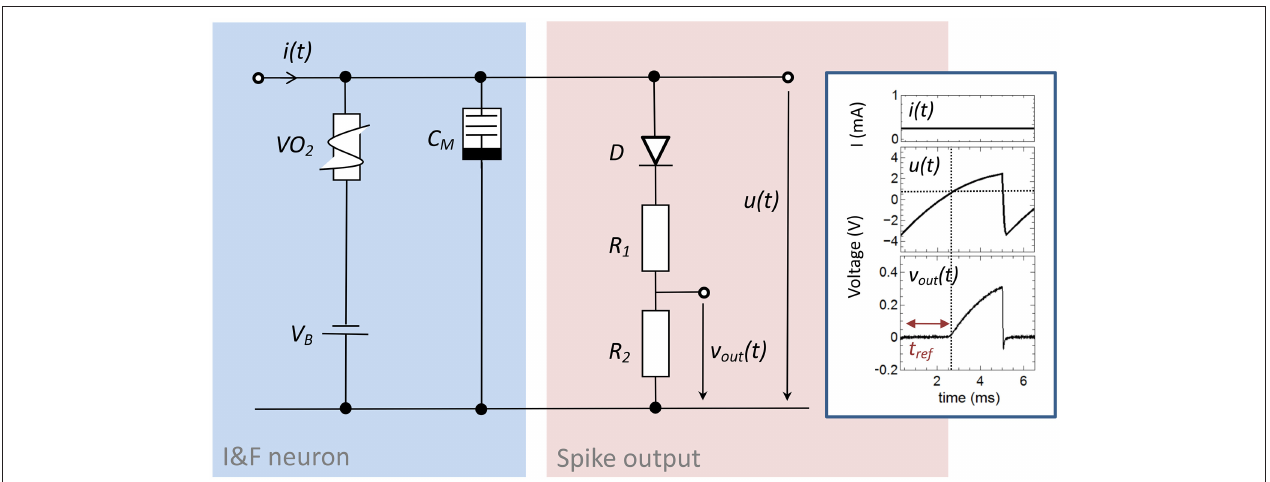
FIGURE 2 | Circuit scheme used to emulate neuronal functionalities: The circuit consists of an integrator circuit (blue) based on a negative differential resistor and a memcapacitor C M , as well as on an output branch with a diode D in series with two ohmic resistors R 1 and R 2 (red) which deliver the spikes v out (t) from the oscillating voltage u(t) . Inset: Typical oscillation for a constant input current of 0.25mA. While the constant voltage source V B shifts the base voltage to a negative value, the voltage divider with the diode D cause a constant output voltage v out (t) in an interval (labeld as t ref ) in which u(t) is smaller than the build-in voltage of the diode. The used device parameters of the circuit were R 1 = 47 k (cid:127) , R 2 = 10 k (cid:127) , C M = C 0 = 0.068 µ F, V B = −